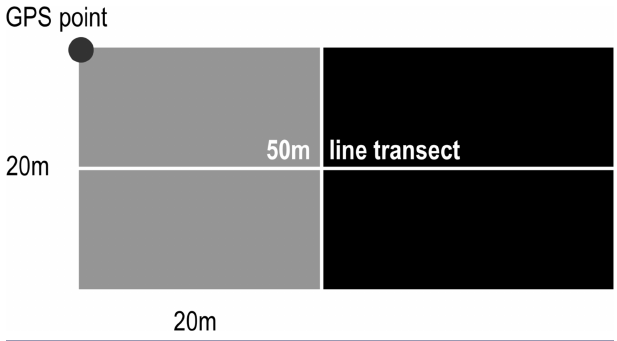
Fig. 1 . Configuration used for data collection. Nested 20 x 20 m (grey) and 50 x 20 m (black and grey) quadrats and a 50 m line transect (white). Adapted from (Gibbons et al.